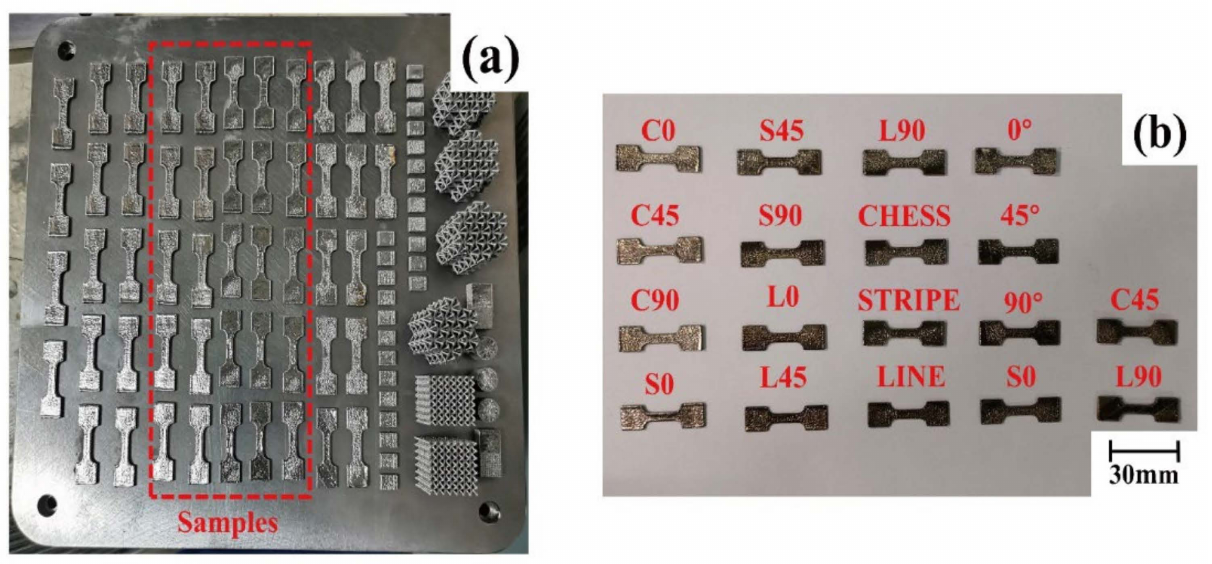
Figure 4. L-PBF forming tensile specimen. ( a ) L-PBF forming sample; ( b ) the actual L-PBF tensile specimen after high-speed wire